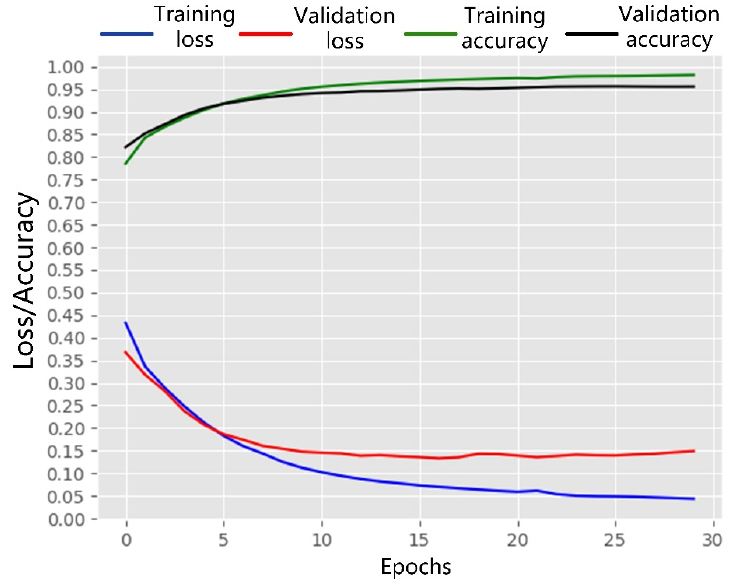
Figure 3. Training loss and accuracy against 30 epochs: training loss (blue); validation loss (red); training accuracy (green); validation accuracy (black).